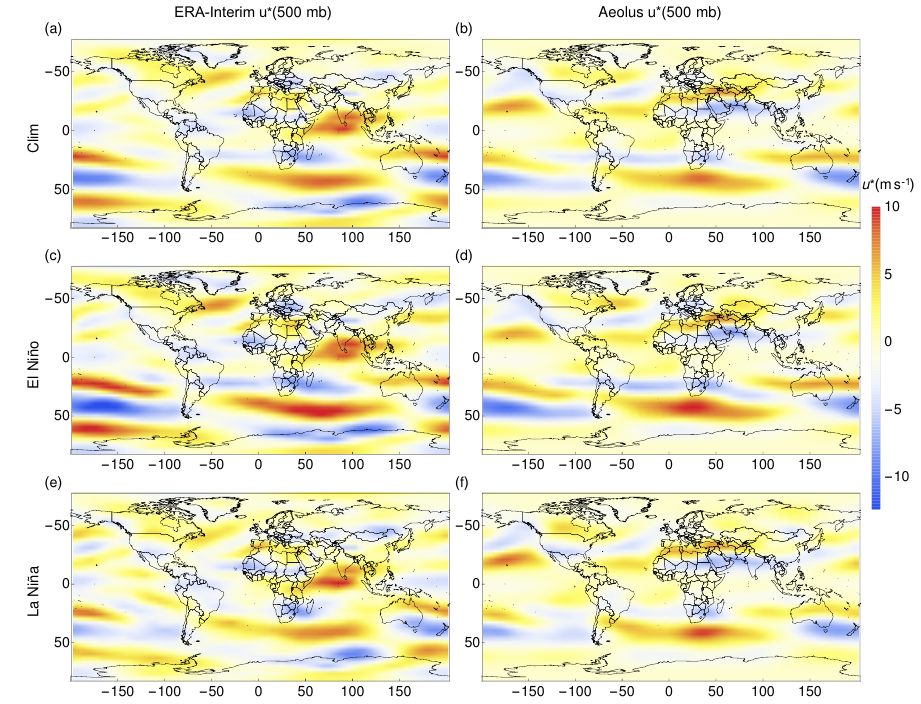
Figure 2. Azonal large-scale zonal wind velocity u ∗ at 500mb for August (compare Fig.